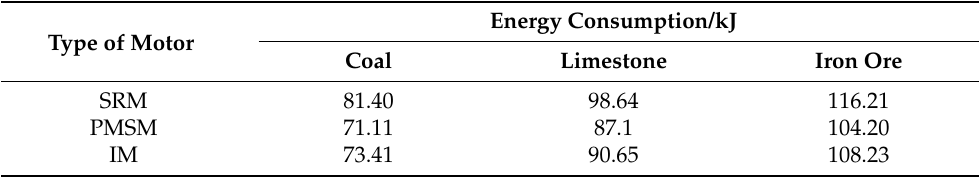
Table 7. Energy consumption for shovelling and unloading conditions.